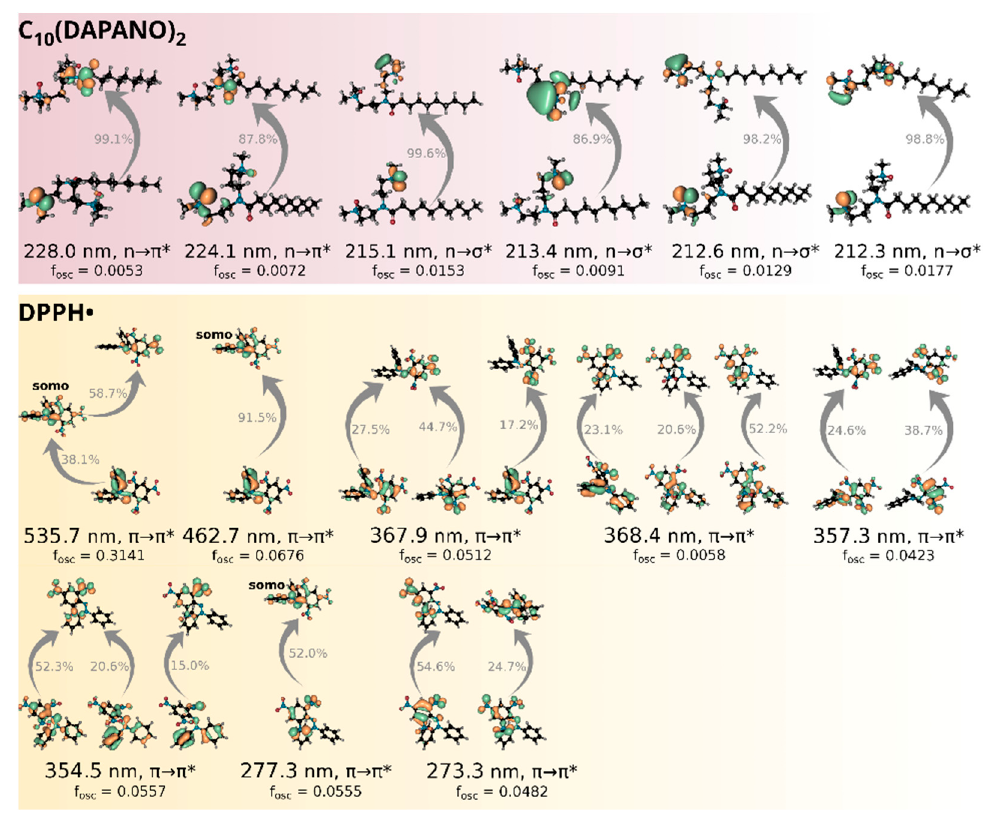
Figure 5. Natural transition orbitals from the time-dependent B3LYP/def2-TZVP computations picturing the most important electronic excited states for C 10 (DAPANO) 2 and DPPH•. For each excited state, only the transitions contributing more than 10% are shown.